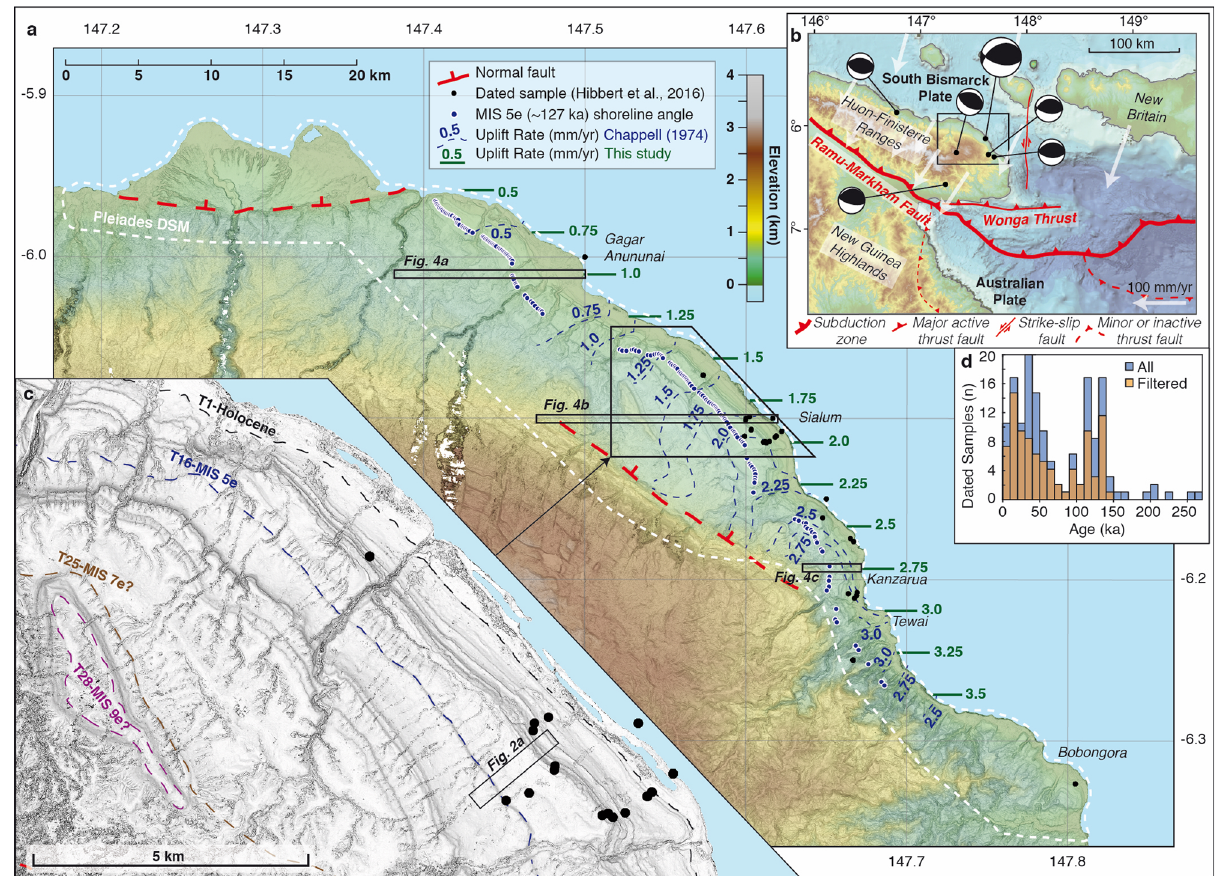
Fig. 1 Uplift rates, dated samples and tectonic context of the Huon coral reef terrace sequence. a Slope map of coral reef terrace sequence overlain with colored elevations, showing a comparison of the uplift rates previously proposed 10 and this study. We also show the location of dated samples, and shoreline angles for the upper MIS 5e ( ∼ 127 ka) terrace. Names in italic refer to the locations of commonly studied sections, of which 3 are modeled in Fig. 4. This map, as well as the ones in b , c , was made using MAPublisher version 9.8 (https://www.avenza.com/help/mapublisher/9.8/). Basemaps were created with Global Mapper version 15 (https://global-mapper.software.informer.com/15.1/). b Regional tectonic setting, with earthquake focal mechanisms of the 1967 and 1992 seismic sequences 87 ranging from m b = 5.5 (smallest) to 6.2 (largest). GPS arrows 25 (white) are drawn with respect to the New Guinea Highlands, as modeled from 66 GPS velocities and 333 earthquake slip vectors. c Detailed DSM slope map of the Sialum area, with mapped paleoshorelines for the coral reef terraces. d Ages of dated samples within a recent coral sample compilation 7 . All samples in blue, and in orange the samples after removing duplicates, samples out of the study area and U/Th open system